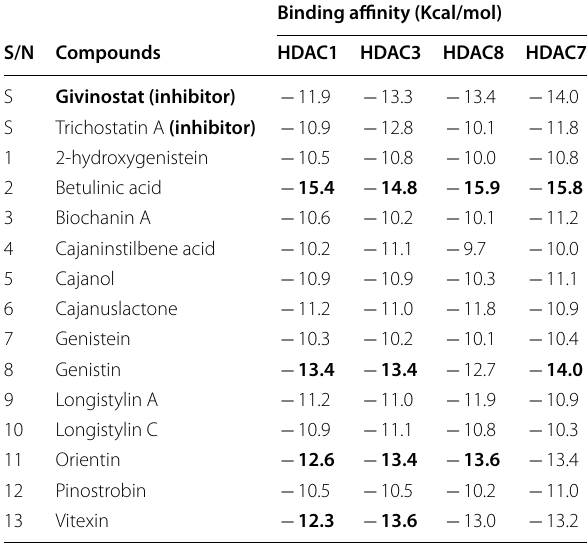
Bold indicates phytocompounds from C. cajan with binding scores greater HDAC known inhibitor (Givinostat)